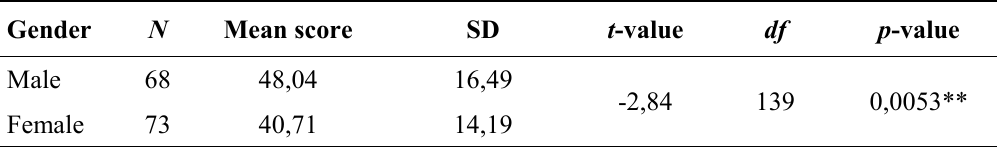
Table 4 : Mean scores in the TPGT by gender